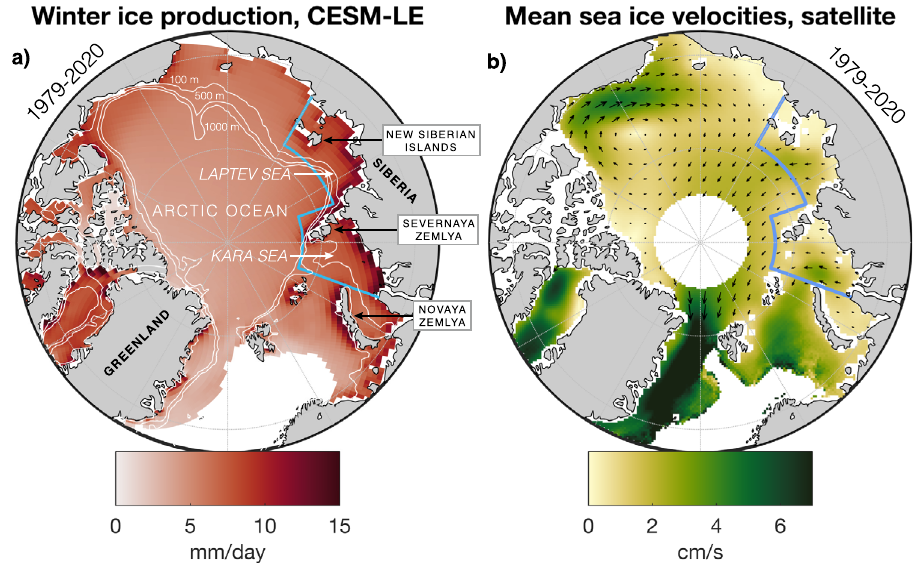
Fig.1|TheKaraandLaptevseas:icefactoriesoftheArcticOcean.a Winter(Oct- Apr) mean ice production for the period 1979--2020 in the ensemble mean of CESM-LE. The Kara and Laptev seas study region is outlined in blue. Bathymetric contours (100m, 500m, 1000m) from CESM-LE shown in white. b Mean sea ice velocities during 1979--2020 as recorded by the Polar Path fi nder v4.1 product,